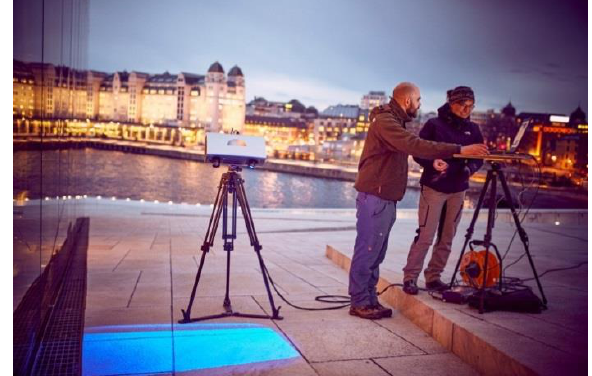
Figure 1. Capturing a trial area at the Oslo Opera House by using the Structured-Light-Scanner Comet